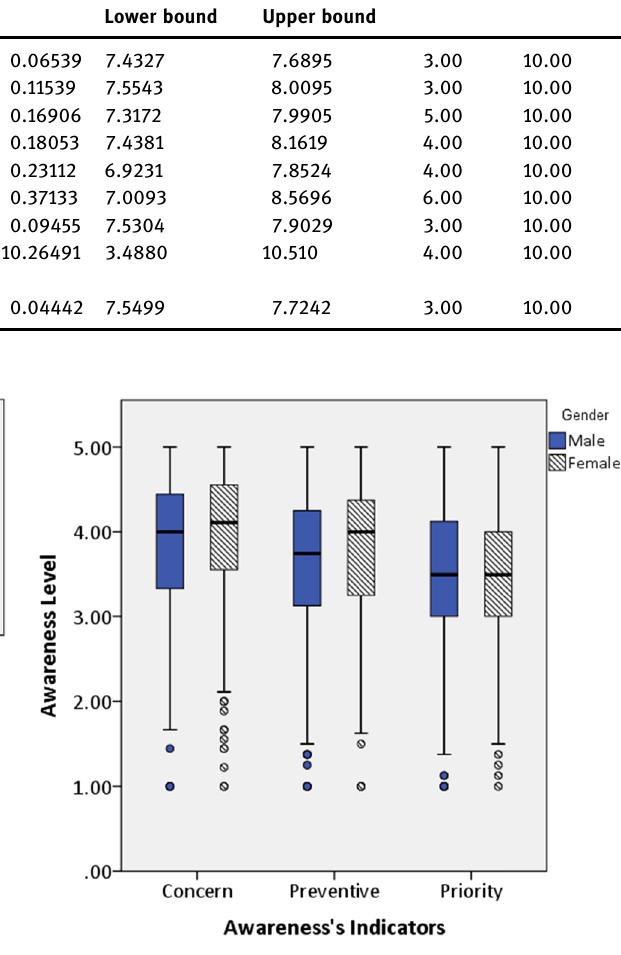
Figure 9: Student ’ s awareness level by